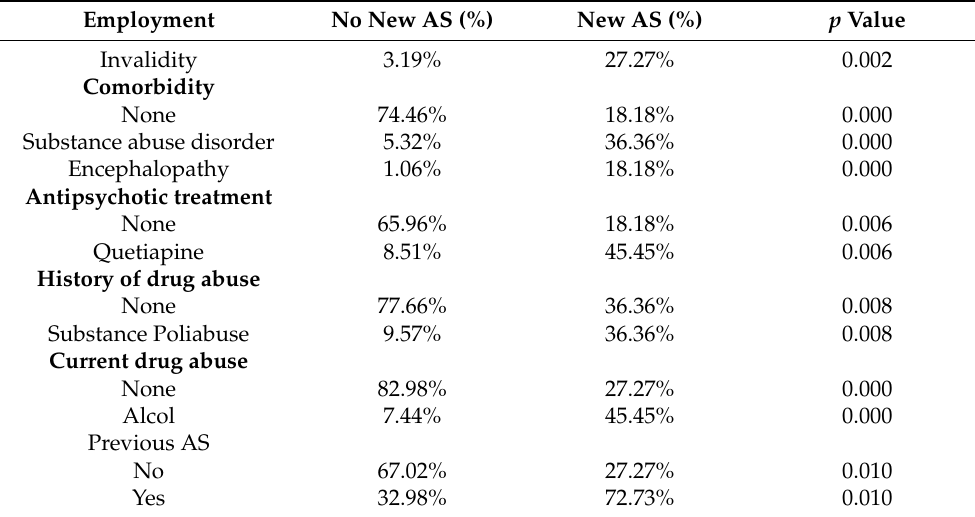
Table 1. Socio-demographic and clinical variables that showed a significant difference in the two groups at follow-up.